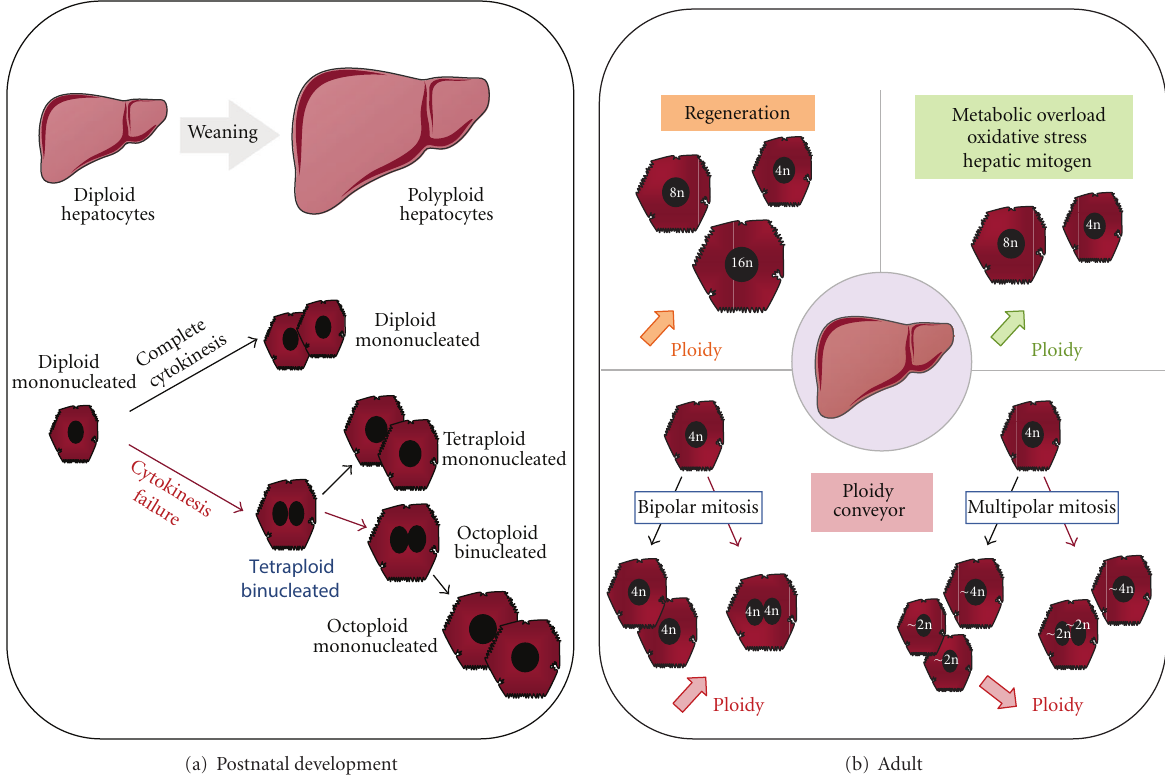
Figure 1: Hepatocytes polyploidization during development and in challenging circumstances: (A) polyploidization during postnatal liver growth. Hepatocytes in newborn are exclusively diploid (mononucleated 2n). At the weaning period, diploid hepatocytes can engage either into normal cell division cycle (black arrow) giving rise to two diploid hepatocytes or follow an adaptive cell cycle with cytokinesis failure (red arrow) giving rise to one binucleated tetraploid hepatocyte. By this process, progressive polyploidization takes place in the liver parenchyma and tetraploid and octoploid cell classes with one or two nuclei are formed. (B) Ploidy modification during physiopathological processes in adult liver. In adult, liver modulates its ploidy in response to di ff erent signals. Liver regeneration induced by partial hepatectomy leads to the disappearance of binucleated hepatocytes and the formation of mononucleated tetraploid and octoploid hepatocytes or even 16n contingent. DNA synthesis induced by chemicals or following oxidative damage and metabolic overload (copper/iron) is associated with a pronounced increase in the proportion of polyploid hepatocytes. Furthermore, in response to di ff erent unknown signals, hepatocytes can both increase (bipolar mitosis followed by cytokinesis failure) or decrease their ploidy (multipolar mitosis). In that case, near-diploid/near- polyploid contingents will be generated, leading to the genesis of genetically distinct daughter cells; black arrow: complete cytokinesis, red arrow: cytokinesis